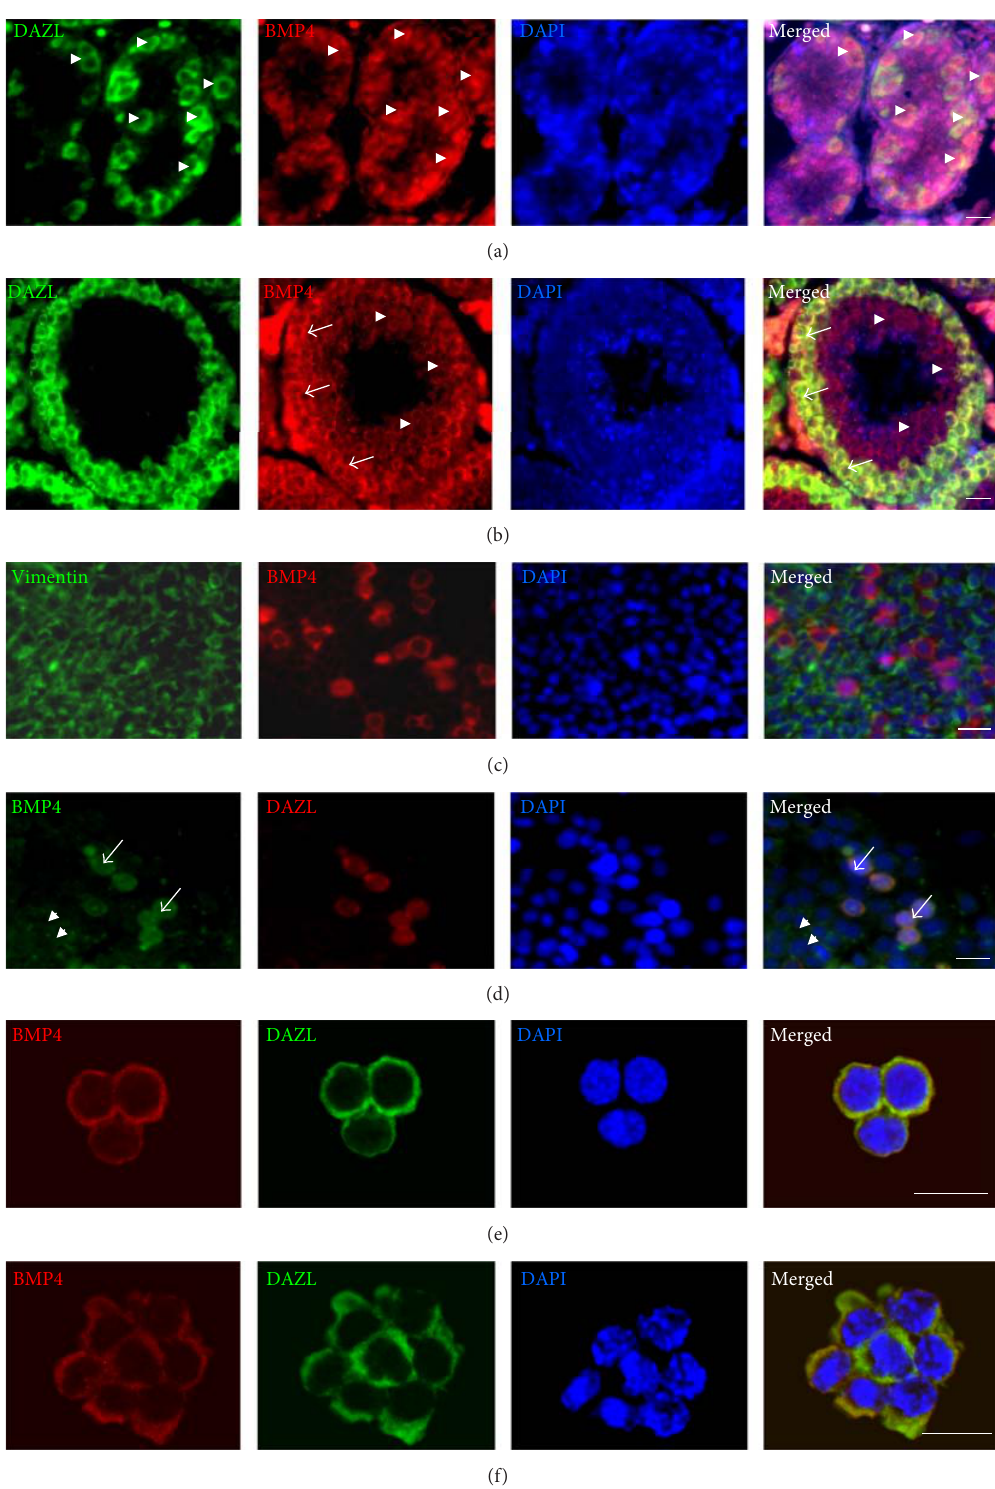
Figure 4: BMP4 protein is mainly expressed in mouse germ cells. (a) IFA analysed the localization of BMP4 and DAZL in 7-day mouse testis section (arrow head). (b) In adult mouse testis section, BMP4 was predominantly expressed in spermatocytes (arrow) and round spermatids (arrow head). (c-d) In testicular cells isolated from 4-5-day mice, BMP4 was predominantly expressed in germ cells (arrow) and, to a less extent, in Sertoli cells (arrow head). (e-f) BMP4 was also expressed in P3 (e) and P33 (f) cultured spermatogonia. Scale bar: 20 𝜇